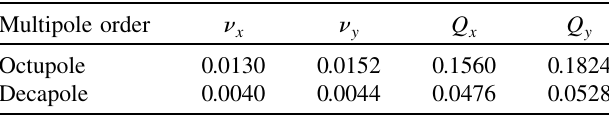
TABLE IV. Variation of cell ( (cid:4) result of changing the order of polynomial fit for rectangular shaped magnets aligned parallel to each other.